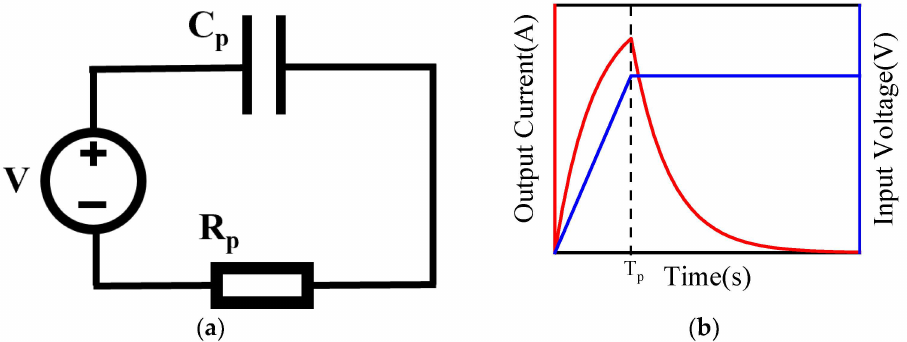
Figure 5. ( a ) Equivalent circuit model of the prompt current and ( b ) input voltage (blue curve) of the voltage source in ( a ) and its output current (red curve).